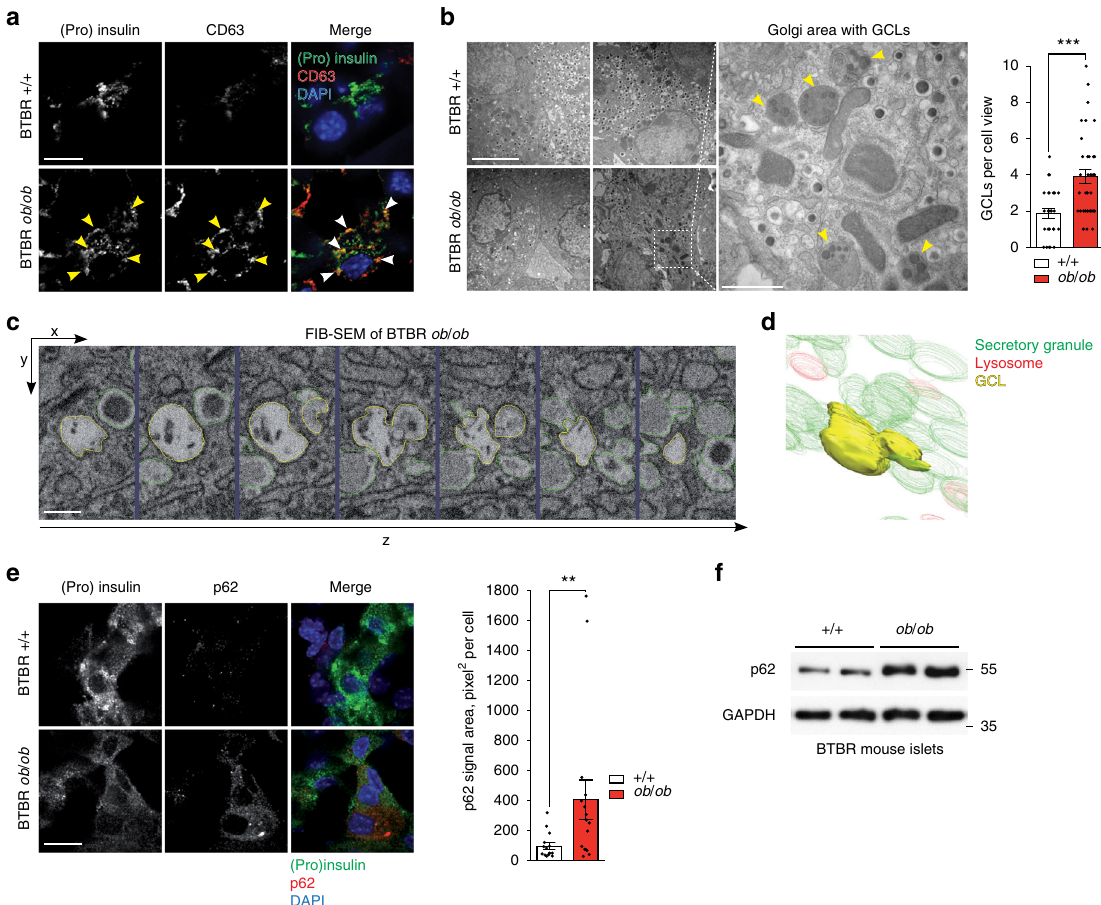
Fig. 3 Increased granule-containing lysosomes (GCLs) and decreased macroautophagy in diabetic mice. a Immuno fl uorescence (IF) of insulin + proinsulin ((pro)insulin) (green) and CD63 (red) in β cells of 8-week-old BTBR + / + and BTBR ob / ob mice. Arrowheads point to (pro)insulin/CD63 co-localization. Scale bar, 20 μ m. b Electron microscopy of β cells in pancreatic islets isolated from 6-week-old BTBR + / + and BTBR ob / ob mice. Yellow arrowheads point to granule-containing lysosomes (GCLs). Scale bar, 5 μ m; for inset: 1 μ m. Quanti fi cation of GCLs per cell view. N + / + = 25 cells and N ob / ob = 36 cells from three mice per each group. *** P < 0.001, Mann – Whitney U -test. c Focused Ion Beam Scanning Electron Microscopy (FIB-SEM) of GCLs of 6-week-old BTBR ob / ob mice. Sequential Z-slices showing GCL (yellow) and neighboring insulin granules (green). Scale bar, 0.2 μ m. d 3D reconstruction of the GCL revealed by FIB-SEM in c . Detailed 3D reconstruction is shown in Supplementary Movie 3. e IF of (pro)insulin (green) and p62 (red) in β cells of 8-week-old BTBR + / + and BTBR ob / ob mice. Scale bar, 20 μ m. Quanti fi cation of p62 signal area: area of p62 signal (pixel²) over a fi xed signal intensity threshold. N N ob = 16, from three mice per each group. ** P < 0.01, Mann-Whitney U-test. f Immunoblot of p62 using lysates of islets isolated from 8-week-old BTBR / ob